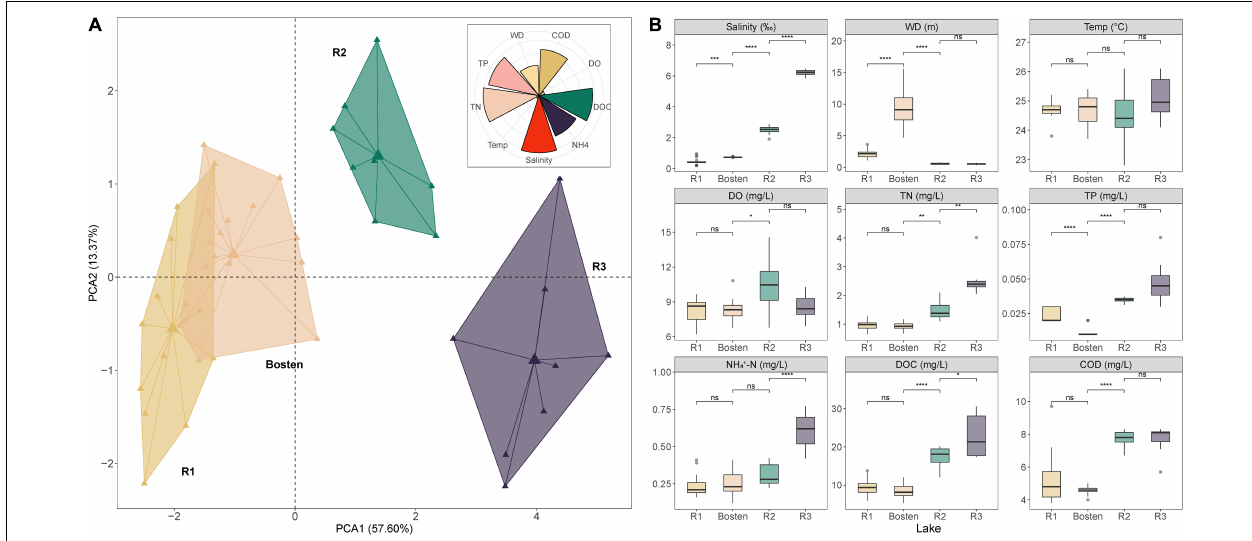
FIGURE 2 | The main environmental characteristics among the four lakes based on salinization and nutrient enrichment gradients. (A) PCA plot of the sampling sites for all lakes. The rose diagram shows the contributions of individual parameters to the total environmental variation. (B) Boxplot comparison of the aquatic environments among the four lakes based on the simulated salinization and nutrient enrichment gradients, using the Kruskal-Wallis test to examine the significance levels of the differences. Significance levels: ns: p > 0.05; * p < 0.05; ** p < 0.01; *** p < 0.001. WD, water depth; Temp, temperature; DO, dissolved oxygen; TN, total nitrogen; TP, total phosphorus; NH 4 + -N, ammonia; DOC, dissolved organic carbon; COD, chemical oxygen demand.